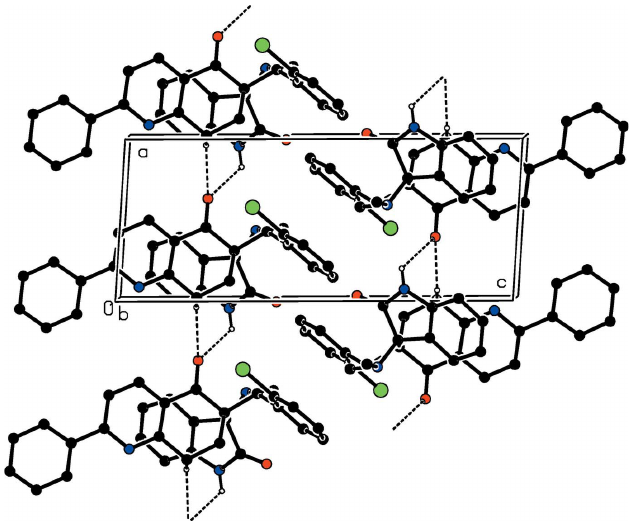
Figure 2 A view along the b axis of the crystal packing of the title compound, illustrating the formation of the hydrogen-bonded (dashed lines; Table 1) chains running along the a -axis direction. H atoms not involved in these interactions have been omitted for clarity.